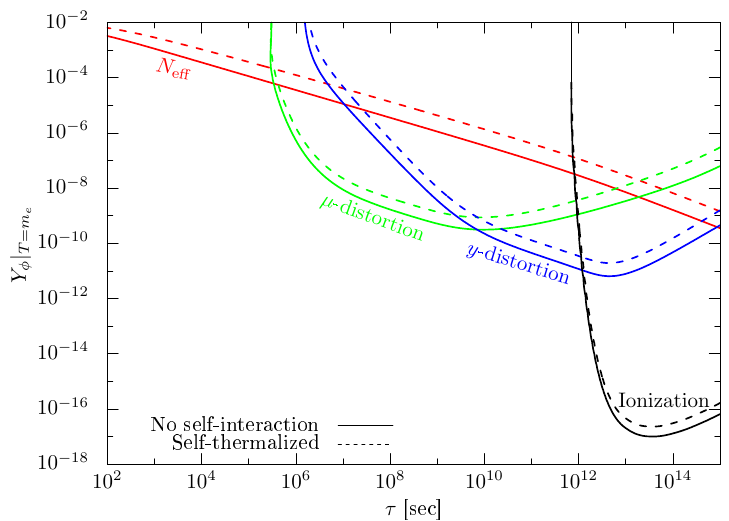
Figure 13. The upper limit on the dark scalar abundance from the CMB constraints for m φ = 2 MeV. The limits roughly scale as m − 1 φ